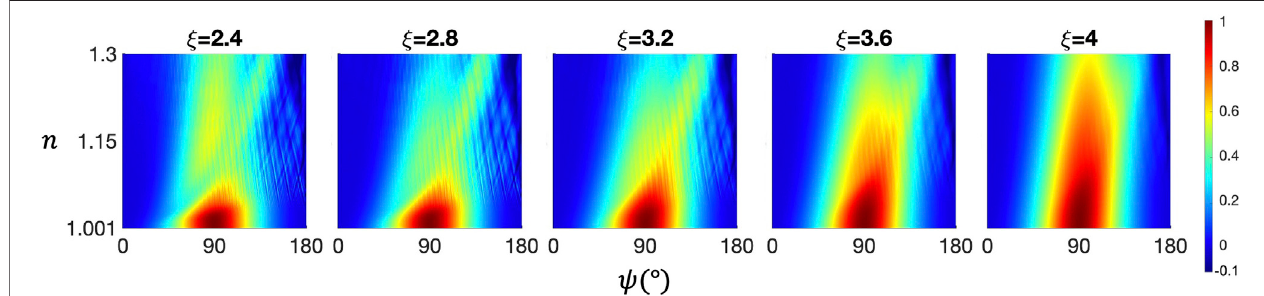
FIGURE 1 | Surface plots of the DoLP angular shape modeled with the Lorenz-Mie light scattering model. X -axes are the scattering angle ψ , y -axes are the particulate refractive indices n . The PSD slope ξ is fi xed for each panel. Color indicates magnitude of the DoLP angular curve.